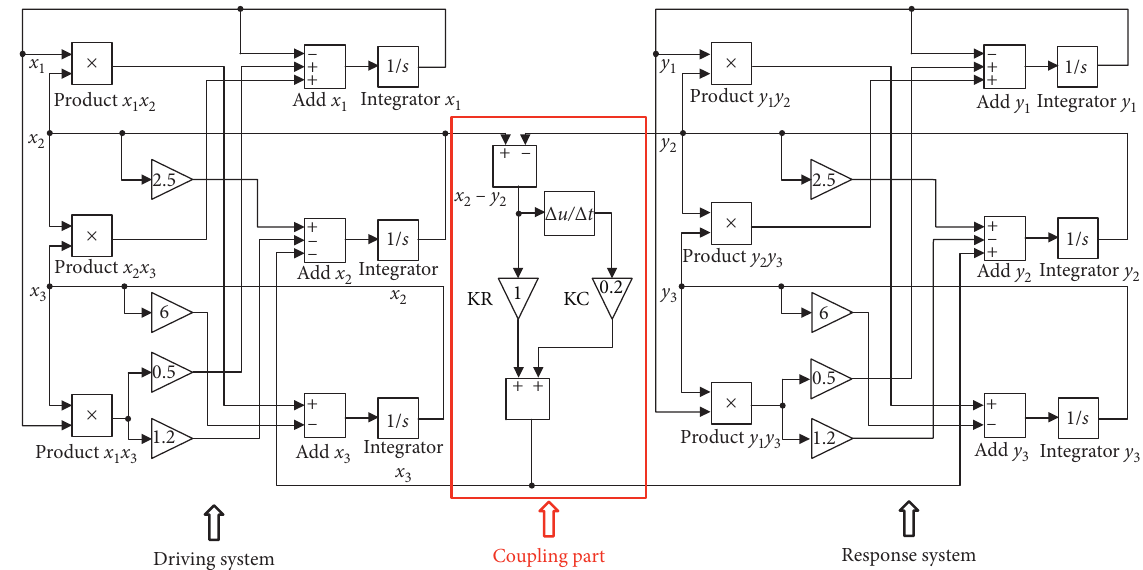
Figure 6: Implementation of the coupled system realized by block diagram in the MATLAB Simulink